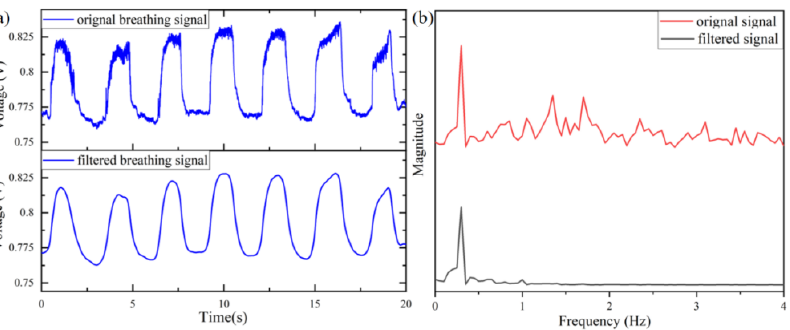
Figure 7. Breath signal recorded by the proposed system. ( a ) Original breathing signal and filtered breathing signal. ( b ) Magnitude analysis of the orignal signal and filtered signal. The volunteer simulated breathing in different states, including normal breathing, deep breathing, shallow breathing, rapid breathing, and apnea. We obtained breathing waveforms of different frequencies and amplitudes. As shown in Figure 8a, the yellow part represents deep breathing, the green part is normal breathing, and the orange part is shallow breathing. The amplitudes of deep breathing are larger than shallow breathing.